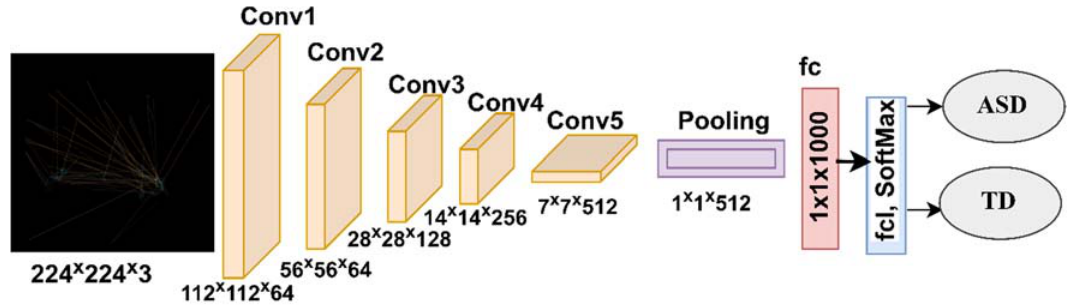
Figure 8. Structure of ResNet ‐ 18